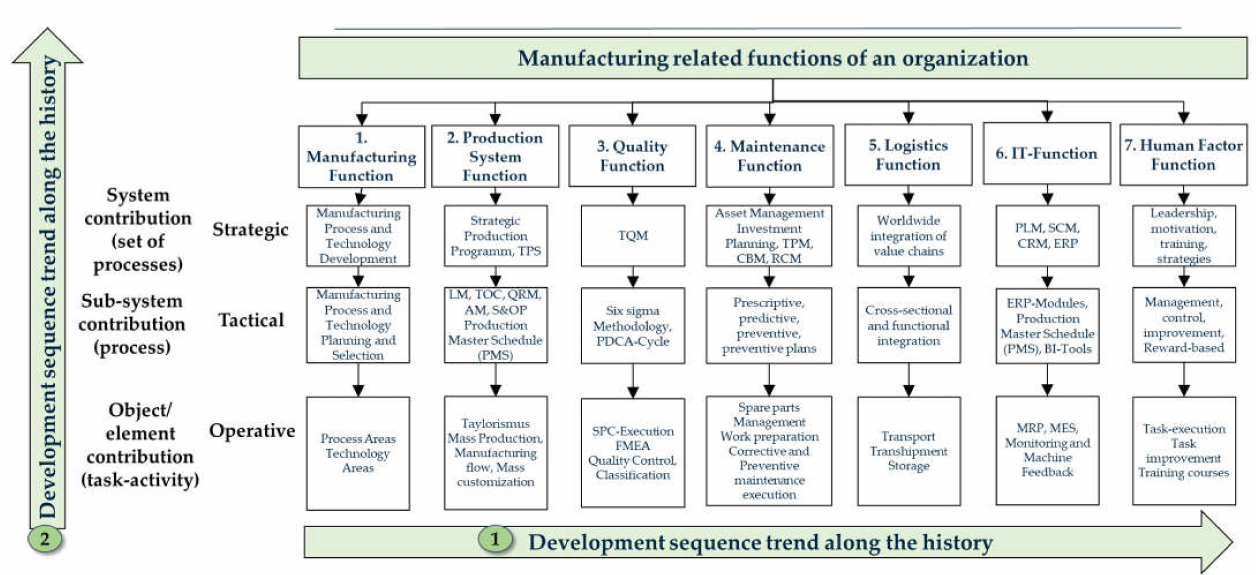
Figure 5. Manufacturing Functions Development within an Organization (own elaboration).